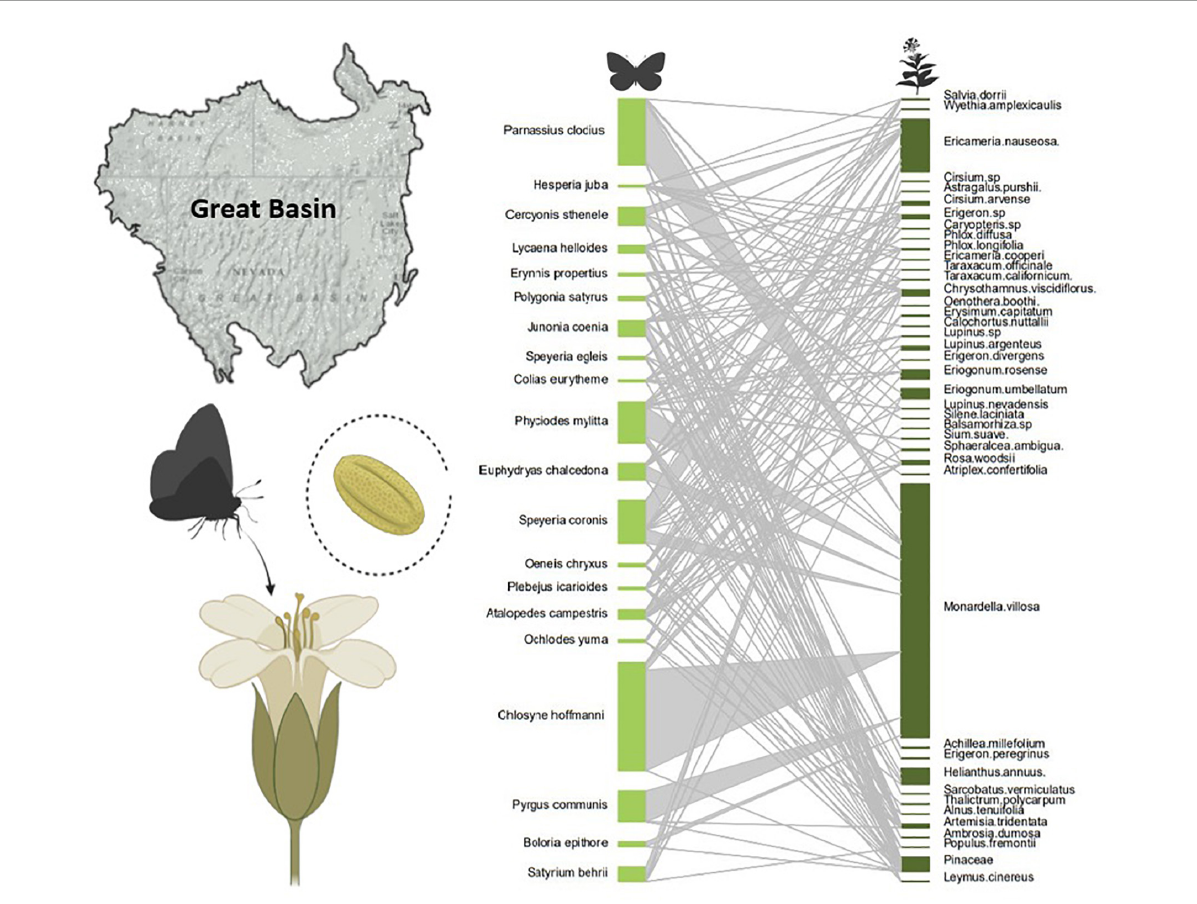
FIGURE5 Bipartite pollen-butterfly networks of 20 butterfly species from museum collections of butterflies in the Great Basin Desert and Sierra Nevada Mountains (United States). Light green nodes are butterfly species, dark green nodes pollen species, and the size of the nodes indicate the frequency of those species in the dataset, while the edge thickness (gray) indicates the frequency of interactions (or strength of the association) between the insect and plant